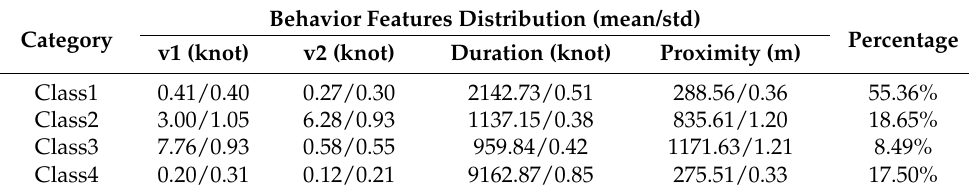
Table 4. Unsupervised clustering model of Brest, France dataset.